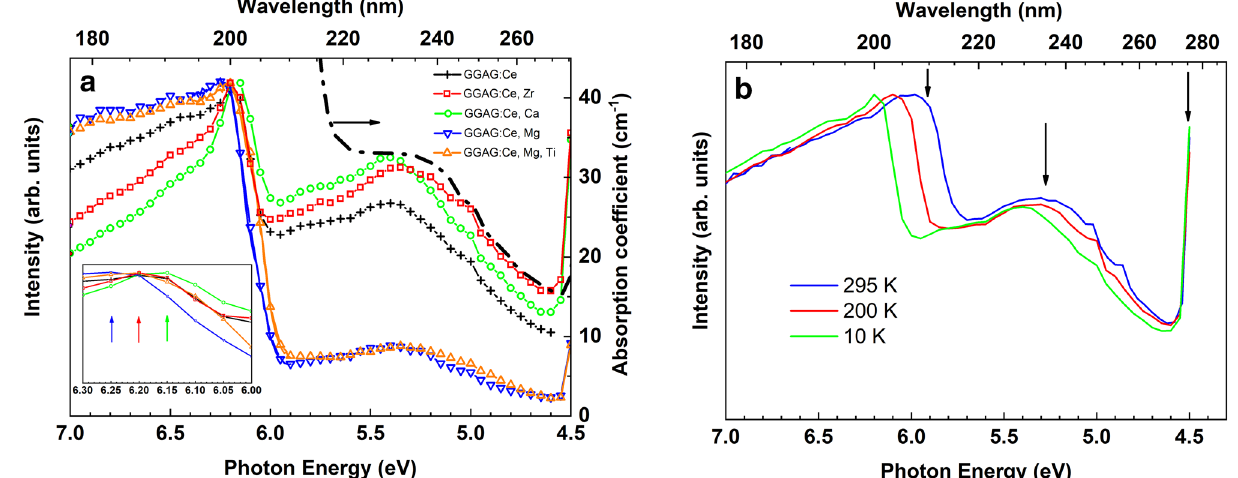
Figure 3. The low energy excitation spectra of Ce 3+ emission (530 nm) in the co-doped GGAG:Ce crystals at 10 K. Dashed line shows the part of the absorption spectrum for the GGAG:Ce single crystal taken from Fig. 1 for the comparison ( a ). Inset ( a ) exhibits the excitonic range of the excitation spectra in details where the colored arrows indicate the position of the corresponding peak (see details in the text). The temperature dependence of the excitation spectra of Ce 3+ emission (530 nm) in the GGAG:Ce crystal ( b ). The arrows show the excitation energies utilized in the time-resolved experiments (see details in the